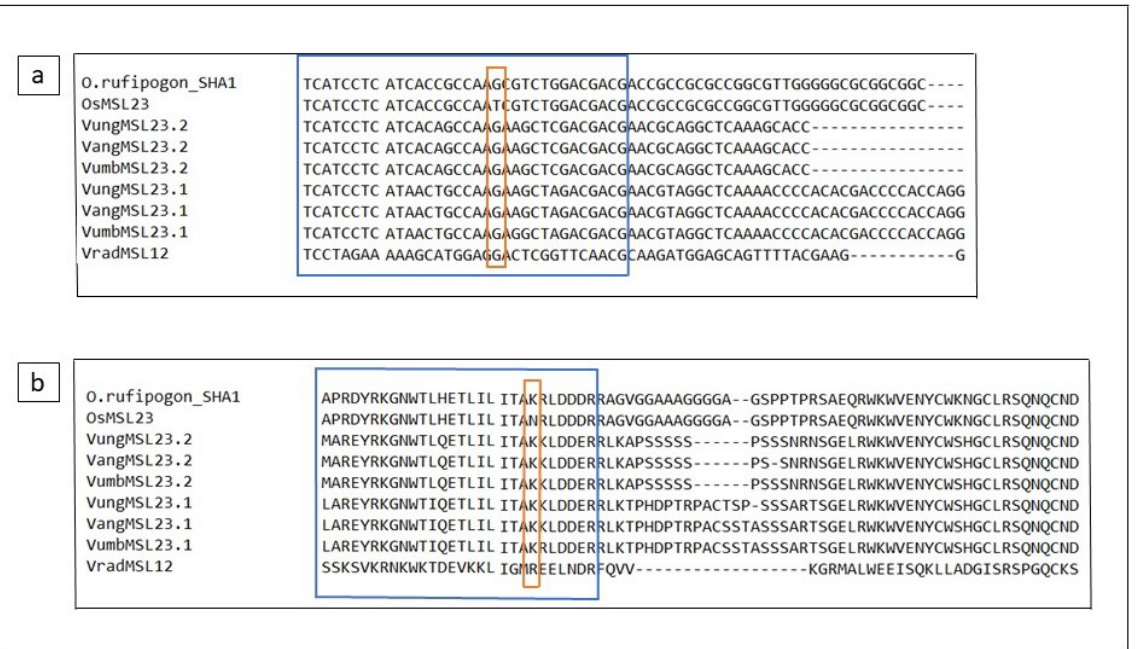
Figure 8. Multiple sequence alignment of SHA1/Sh4 orthologs in Vigna crops ( a ) Alignment between the coding sequences ( a ) and amino acid sequences ( b ) of SHA1 of O. rufipogon, OsMSL23 of cultivated rice and respective orthologs in Vigna . The box with orange lines highlights single nucleotide (G to T) and amino acid (K to N) variations in respective crops.